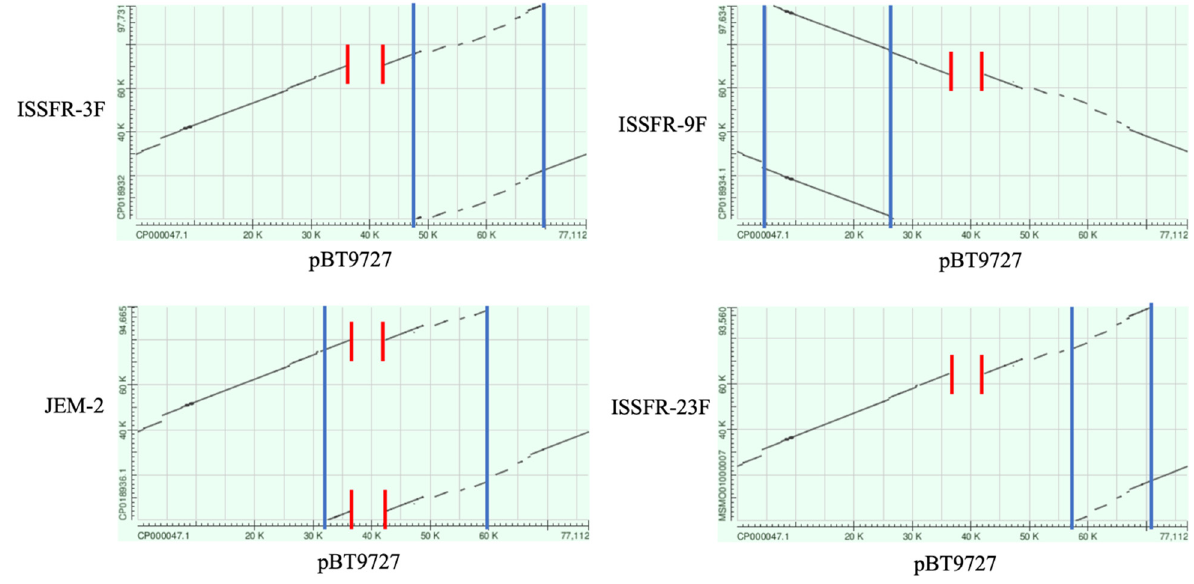
Figure 7. Dot Plot representations (BLAST score ratio-based synteny plots) of alignments between B. thuringiensis serovar konkukian 97-27 plasmid pBT9727 (X-axis) and the ISS Bacillus strains (Y-axis, ISSFR-3F, ISSFR-9F, JEM-2 and ISSFR-23F from top left to bottom right, respectively). Each point on the figure represents an individual peptide in pBT9727 compared to the proteome of the ISS plasmids. Red lines indicate the region containing a hypothetical IS231 transposase in pBT9727 absent in the ISS Bacillus plasmids. Based on the sequences present in GeneBank, the plasmid regions between the Blu lines are duplicated regions in the ISS plasmids. The ISSFR-9F plasmid shows a reverse relative orientation compared with pBT9727. GeneBank accession numbers: B. thuringiensis serovar konkukian pBT9727 plasmid CP000047.1, 77112 bp. Bacillus ISSFR-3F plasmid CP018932,